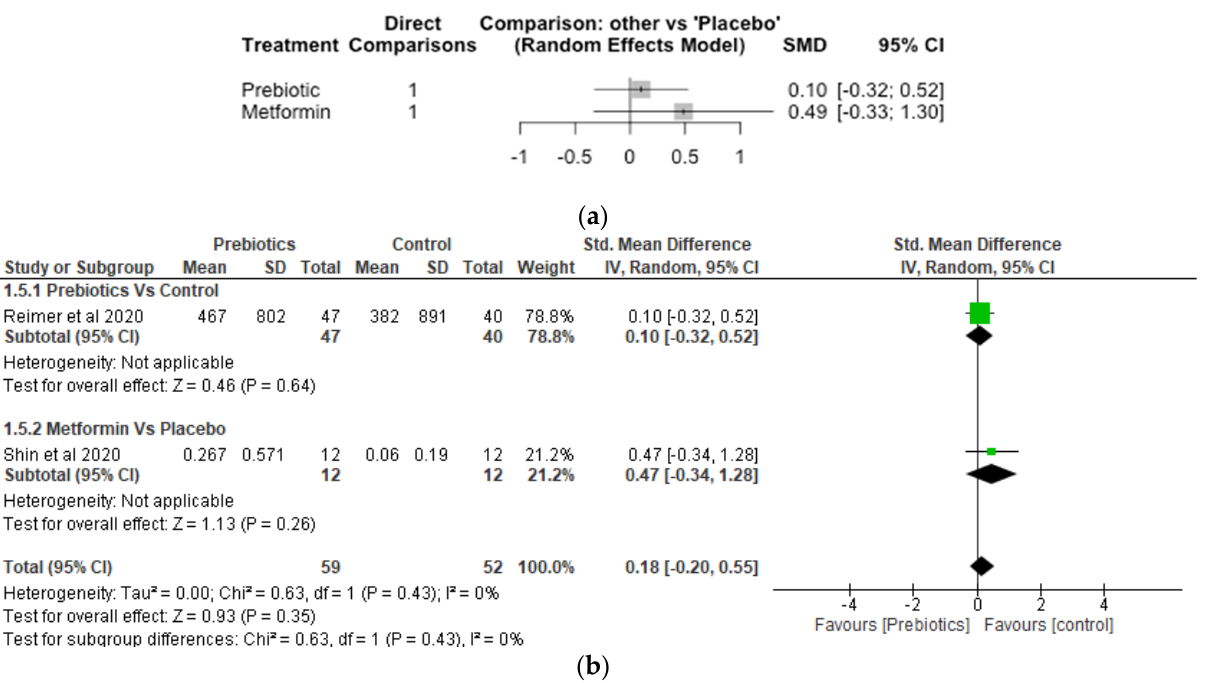
Figure 4. Network Meta-analysis ( a ) and Meta-analysis ( b ) of the effect of treatments versus control on Lactobaccilus [37,41,42].